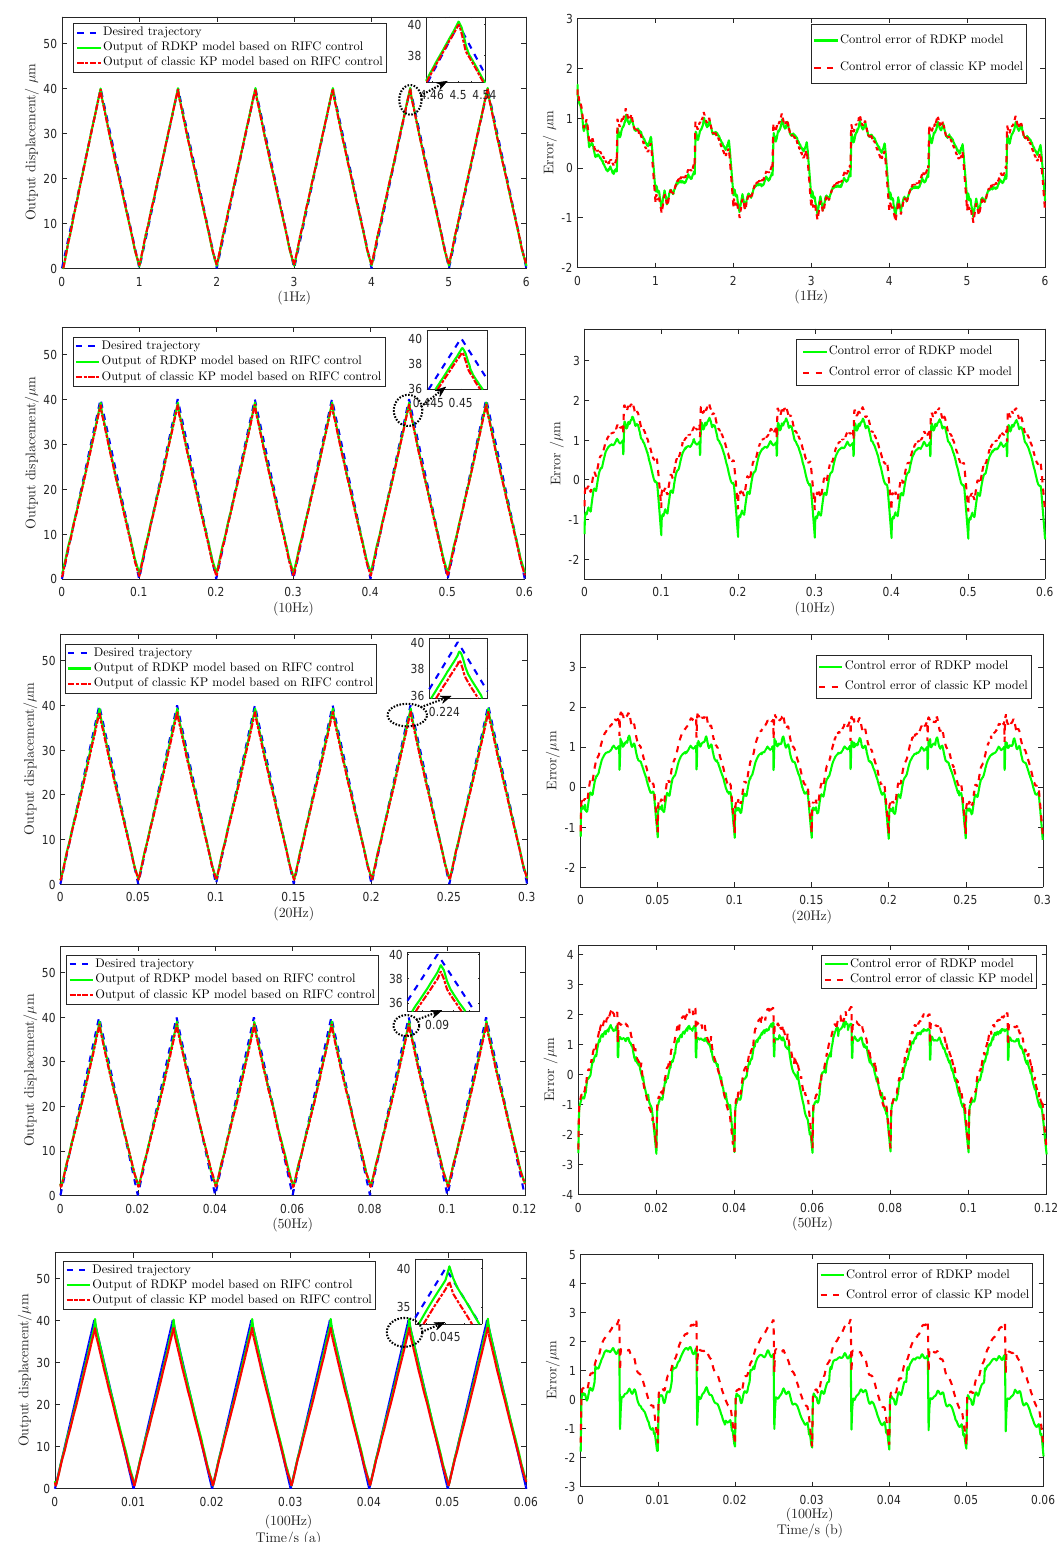
Figure 13. The tracking performance of the RDKP model and classic KP model based on RIFC control with diverse input voltage frequency, including ( a ) the desired and control output tracking displacements ( b ) control errors of the proposed RDKP model and classic KP